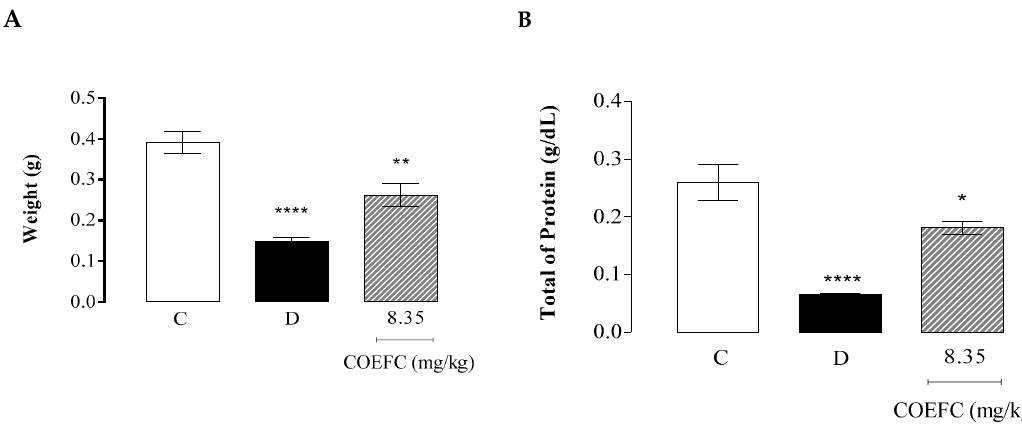
Figure 7. Effect of the COEFC (8.35 mg/kg/p.o.) on granuloma induced by the implantation of cotton pellets; ( A ) Mass (g) of the pellets and ( B ) total protein (g/dL). Mass of the cotton pellets dry (A) and quantification of total proteins (B) between the control (C) mL/10 g/vol), dexamethasone (D) (5 mg/kg/p.o.), and COEFC (8.35 mg/kg/p.o). Values represent the mean ± S.P.M. ( n = 6/group). * p < 0.05; ** p < 0.01; **** p < 0.0001 vs. control; Statistical analysis: ANOVA followed by the Dunnett’s test with multiple comparisons.